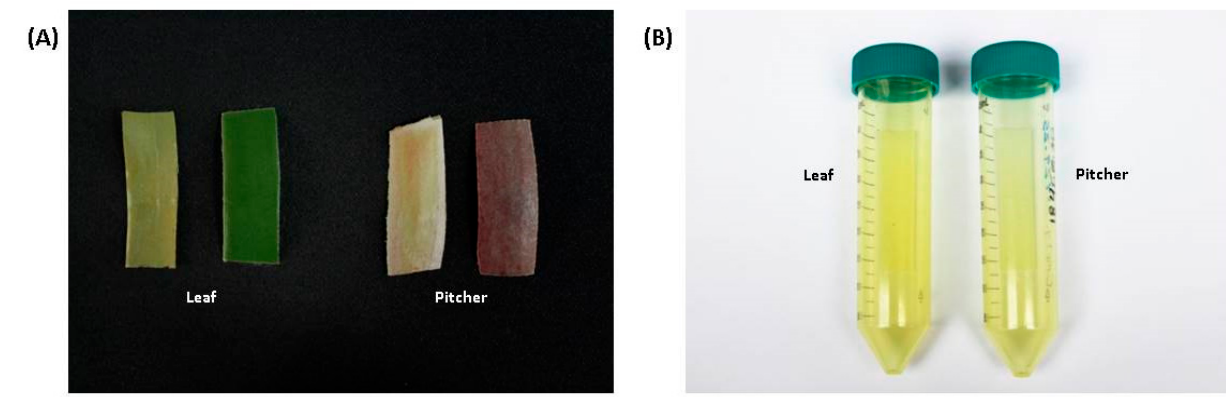
Figure 3. ( A ) Tissues of dry Nepenthes x ventrata leaf and pitcher stored for 6 months in a plastic tube. Sublimed compounds cover the dry material with a yellowish color (left) in comparison with freshly cut tissue (right). ( B ) Plastic tubes that stored the different tissue types for 6 months. New tubes do not show any color. After evaporation of the solvent, the residue was used for NMR analysis. In parallel, leaf extracts from N. x ventrata were analyzed by 1 H-NMR as well (Figure 4). When compared with a reference, it could be confirmed that the sublimed volatile compound was indeed plumbagin, and this compound could also be proven in leaf material (Figure 4).